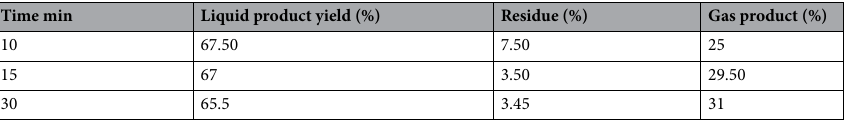
Table 5. Results of cracking time effect on thermo catalytic cracking process*. WCO Feed = 100 g, T = 450 °C, Catalyst Load = 2.5 g, Initial Pressure of Nitrogen = 5 bar.